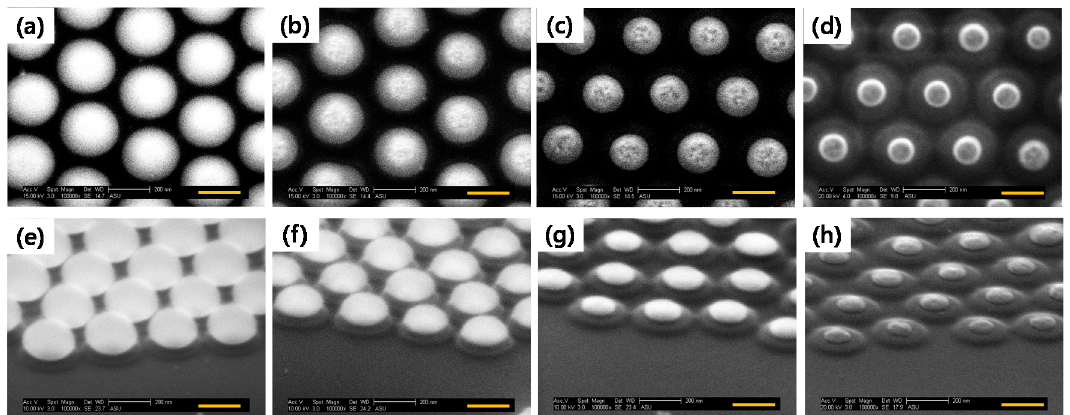
Figure 3. Top ( a – d ) and 25°-tilted ( e – h ) SEM images of SNSs after CHF 3 /Ar gases etching with four different etching times: ( a , e ) 50 s, ( b , f ) 90 s, ( c , g ) 150 s, and ( d , h ) 180 s.